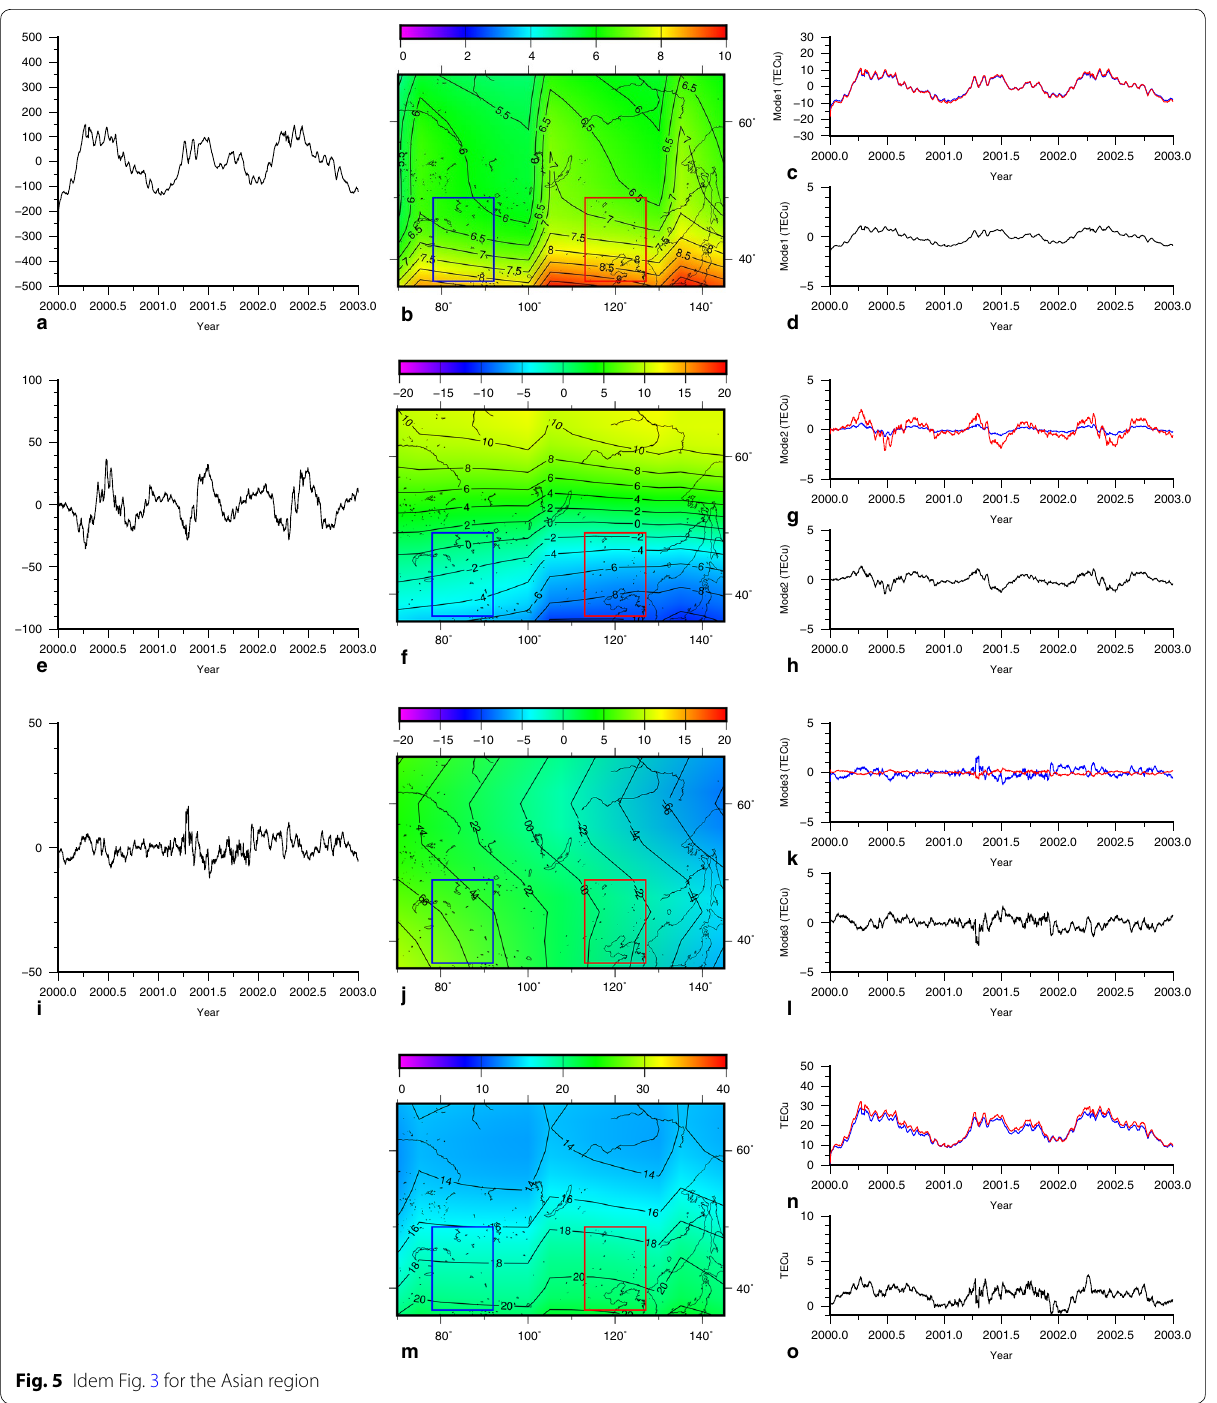
Fig. 5 Idem Fig. 3 for the Asian